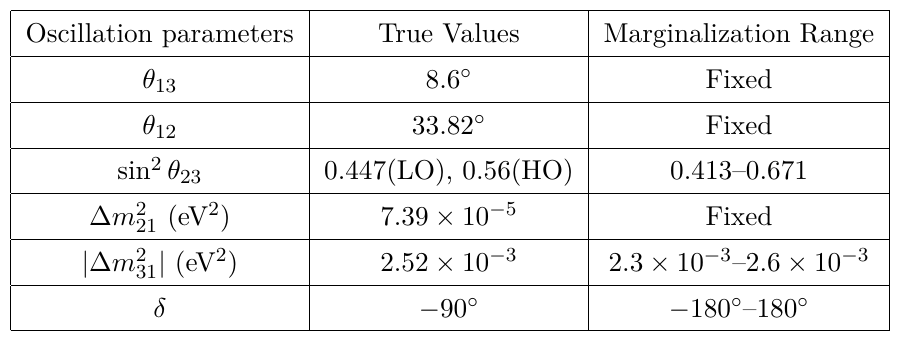
Table 3 . The values of the 3 neutrino oscillation parameters [1, 70] used in the present analysis unless stated